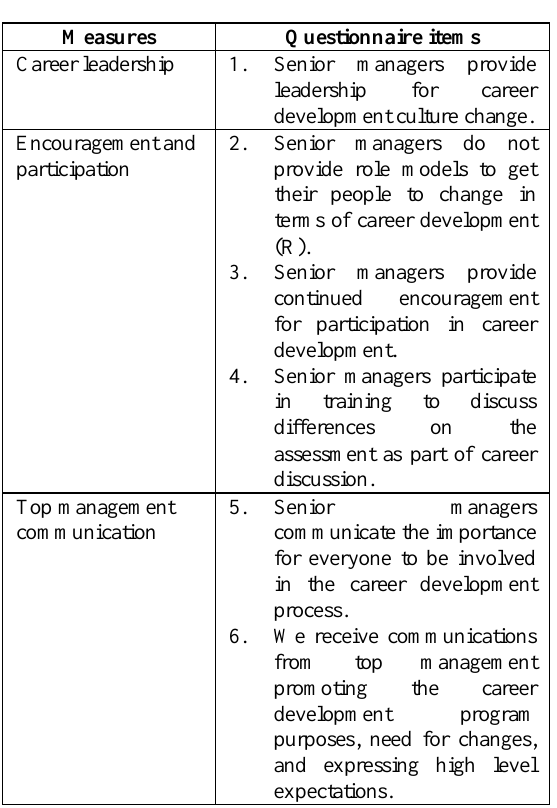
Table 2: Scale of Career Support of Senior Management